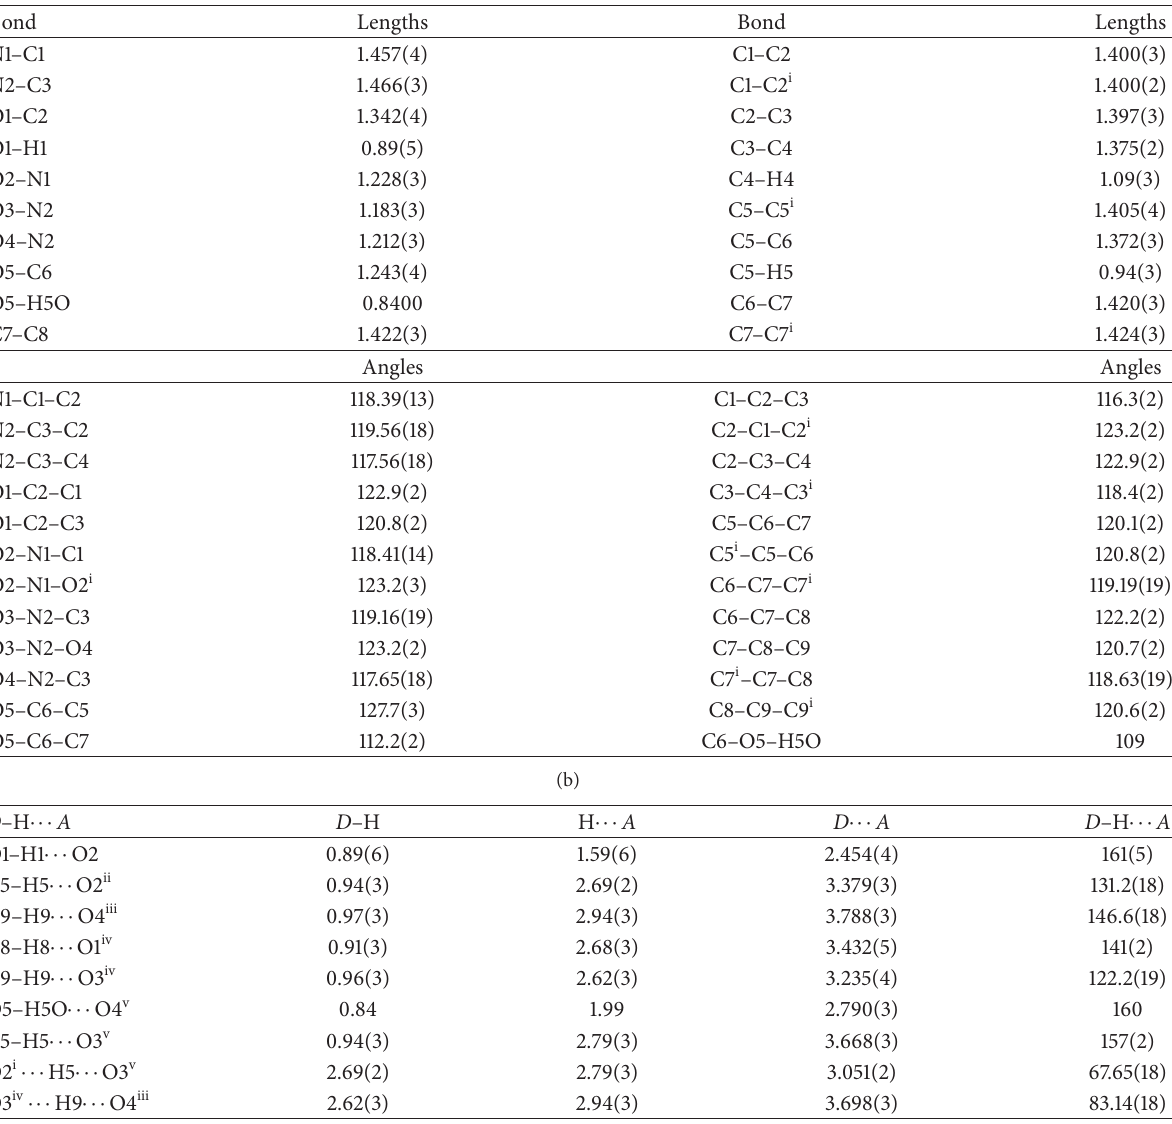
Table 2: Selected interatomic distances, angles, and hydrogen bond geometries (˚A, ∘ ).